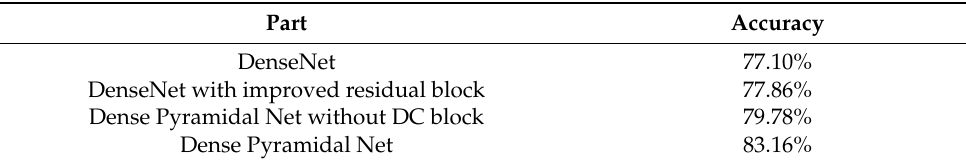
Table 1. Comparison results of each part on Cifar10.